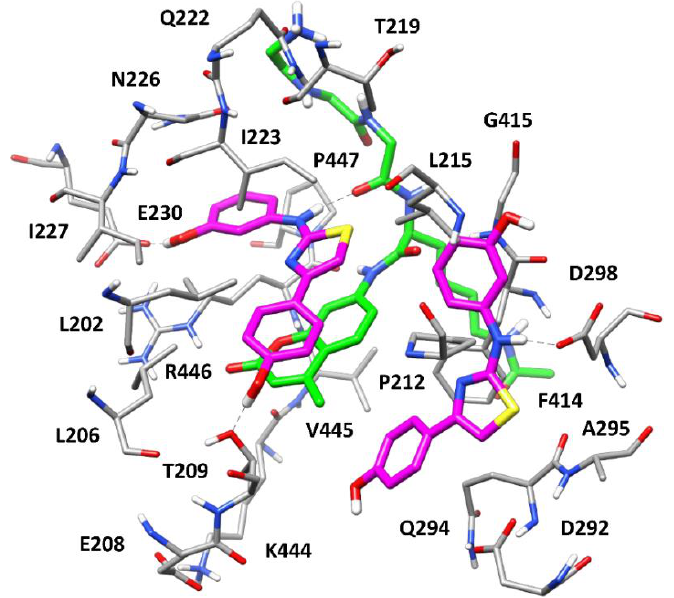
Figure 6. Minimized average structure of SIRT1 in complex with p53-AMC peptide (green) and two molecules of compound 8 (purple). The ligand–protein and ligand–peptide H-bonds are highlighted as black dashed lines. For clarity, the side chains of R1, H2, and K3 of p53-AMC are not shown.